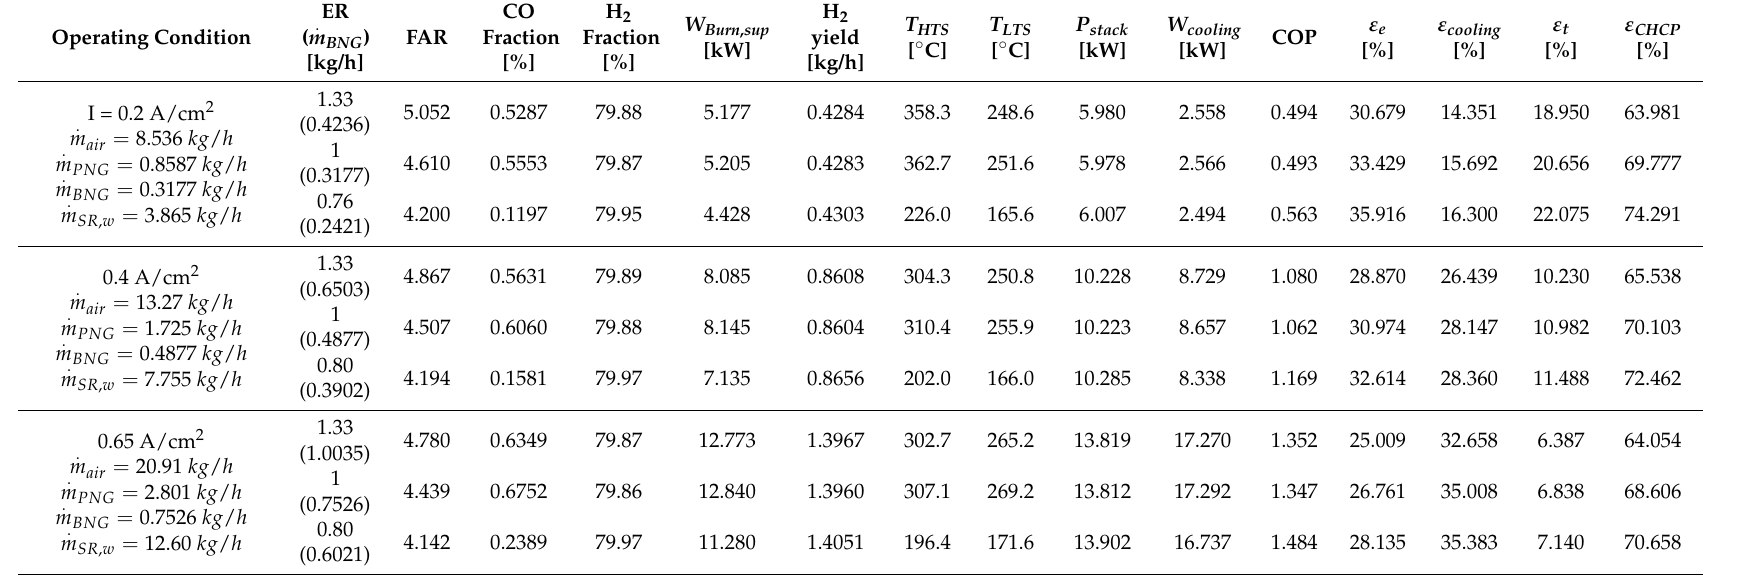
Table 4. Effects of fuel-air ratio (FAR) for the burner on the performance of the tri-generation